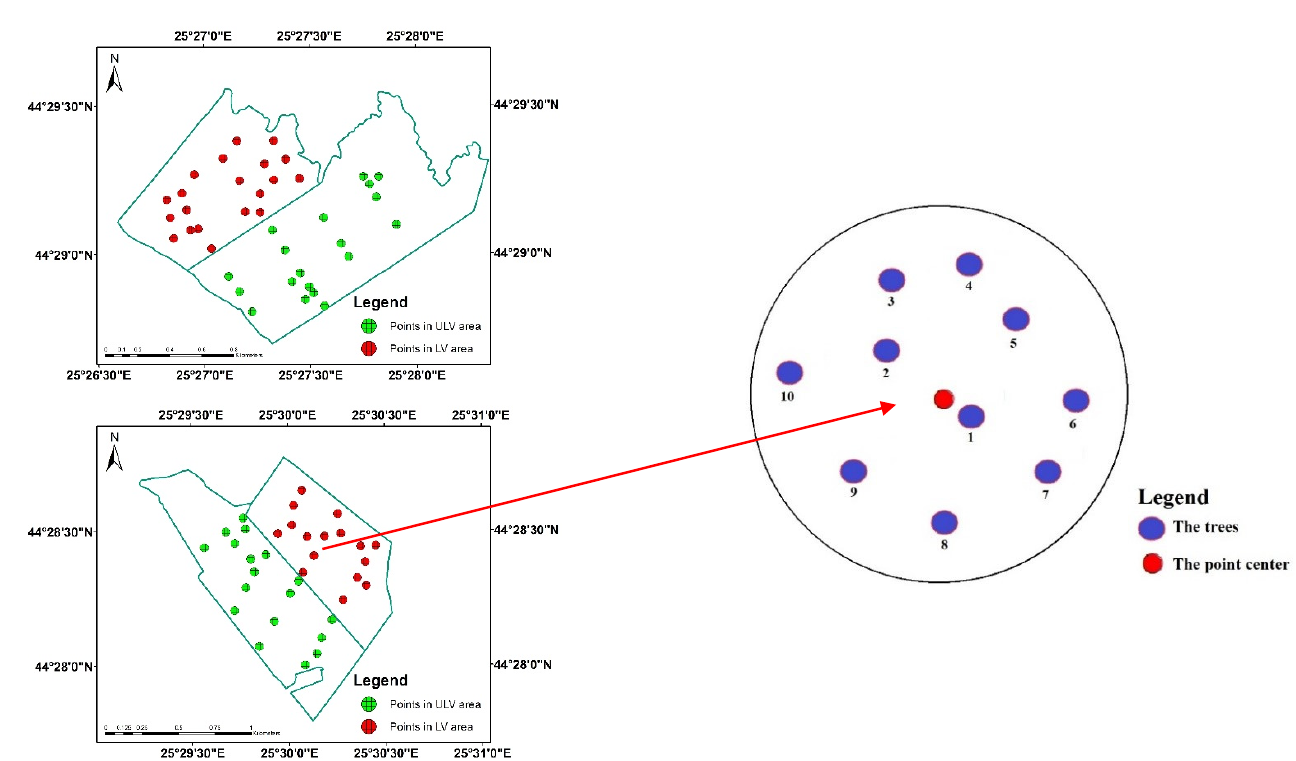
Figure 3. The network of observation points established to assess the level of damage caused by Corythucha arcuata .